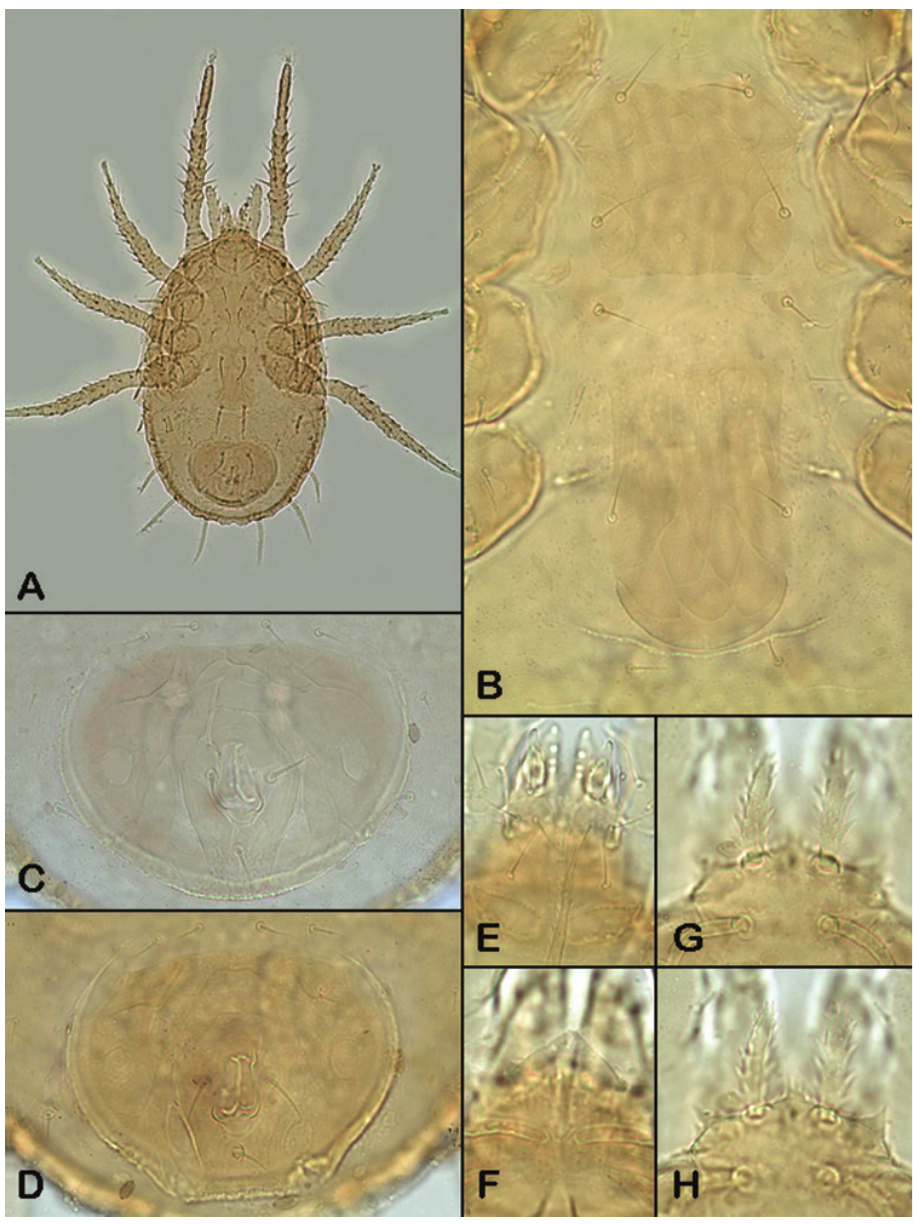
Plate 21. Ameroseius lidiae , female. A Dorsal idiosoma with legs B Sternal and epigynal shield C–D Anal shield, variant forms E Hypostome, ventral view F Epistome G–H Setae j1 and dentation of